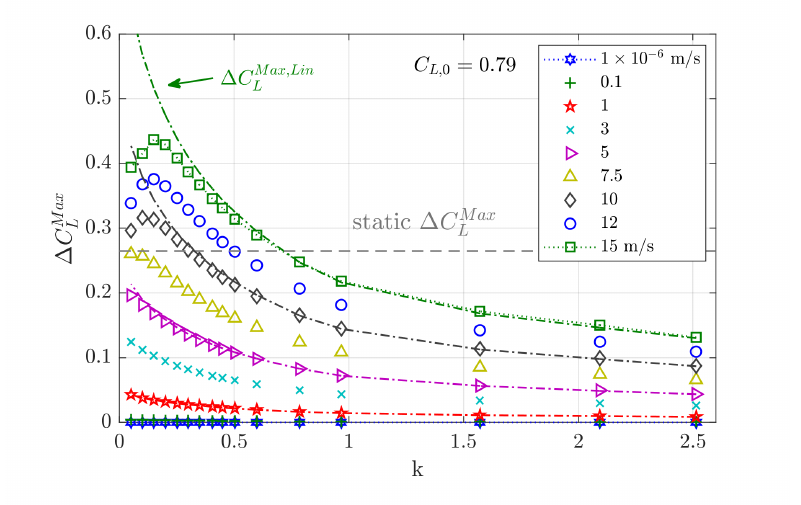
Figure 10. Maximum lift during one period of excitation at Mach 0.70, compared to ∆ C Max , Lin